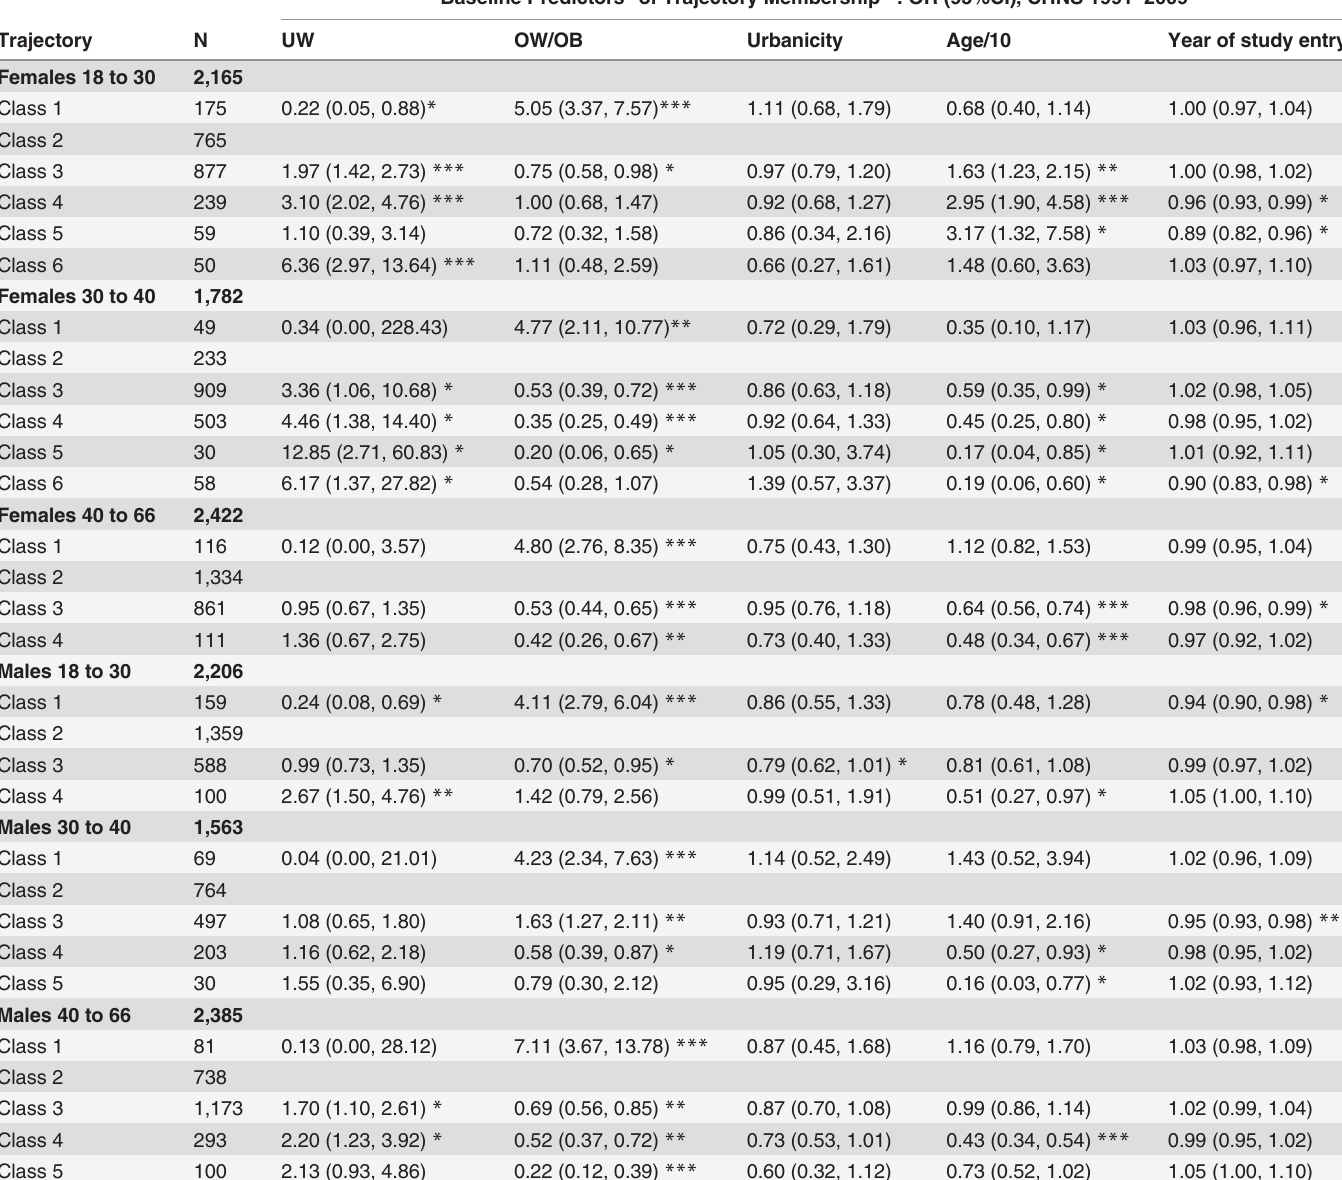
Table 3. Odds Ratios and 95% Con fi dence Intervals for Baseline Covariates Related to Trajectory Membership, China Health and Nutrition